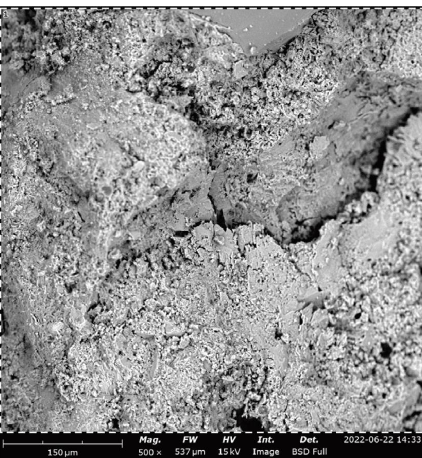
Figure 29: SEM for M2 sample.